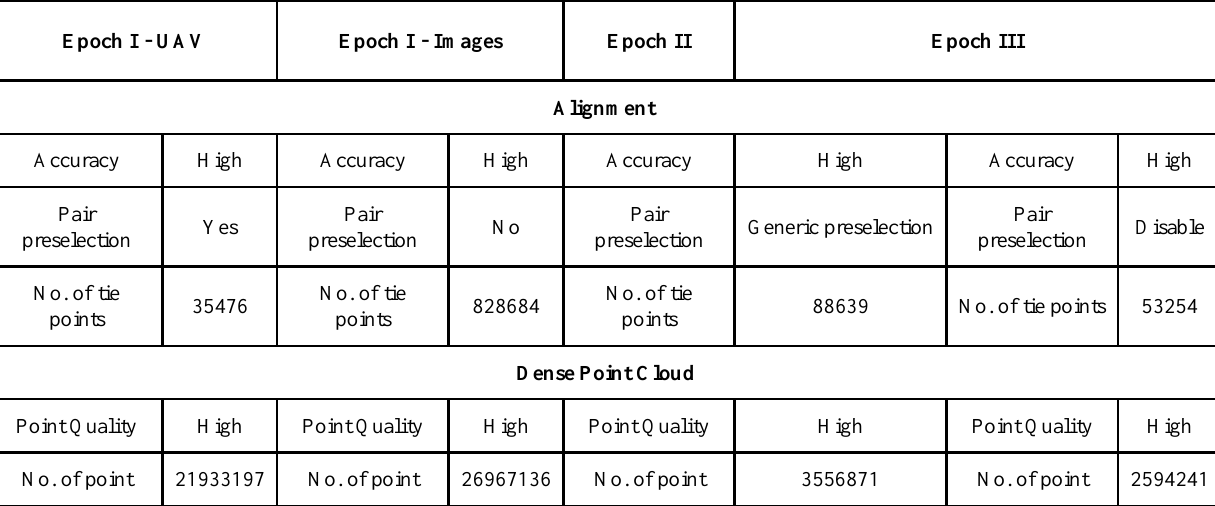
Table 3. The main parameters used in image